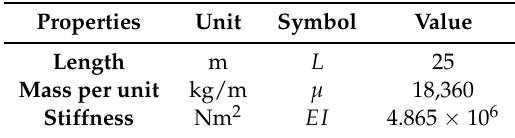
Figure 4. The schematic view of the simply supported beam under moving sprung mass. Table 2. Properties of the simply supported beam.